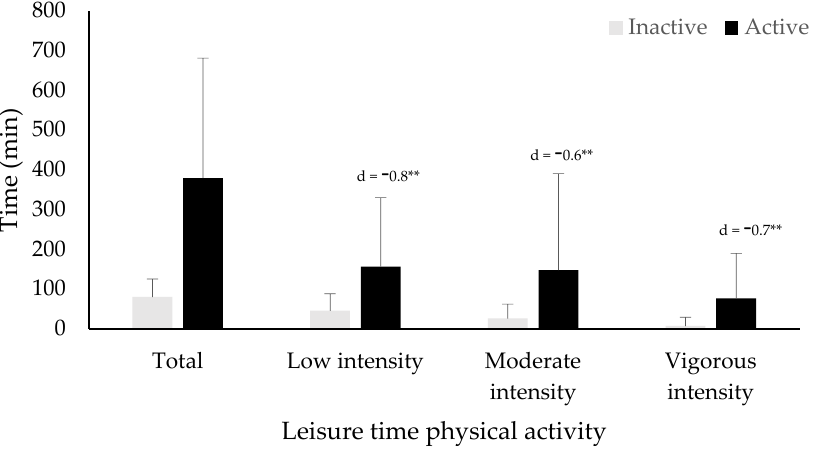
Figure 1. Results of weekly LTPA minutes for both inactive (<150 min per week) and active (>150 min per week) women. ** p < 0.001, significant differences between the inactive and active groups.